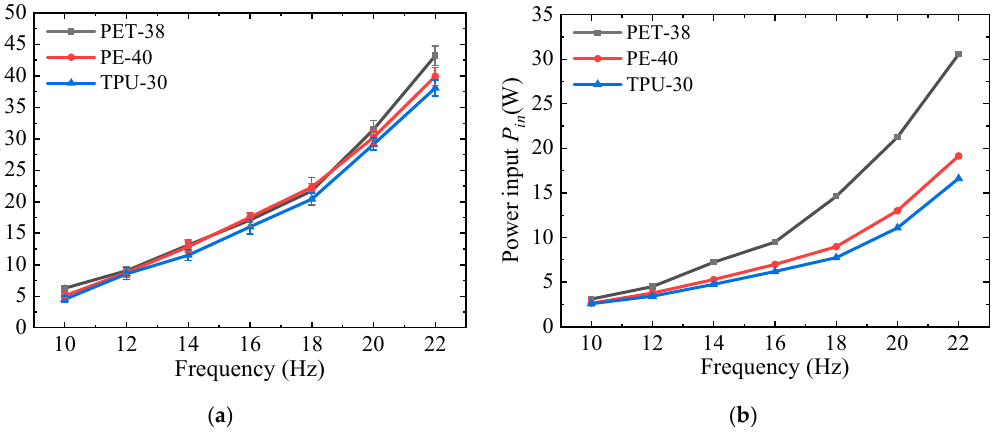
Figure 7. Measured force and power input for the three wings at various flapping frequencies. ( a ) Mean lift force; ( b ) Power input.